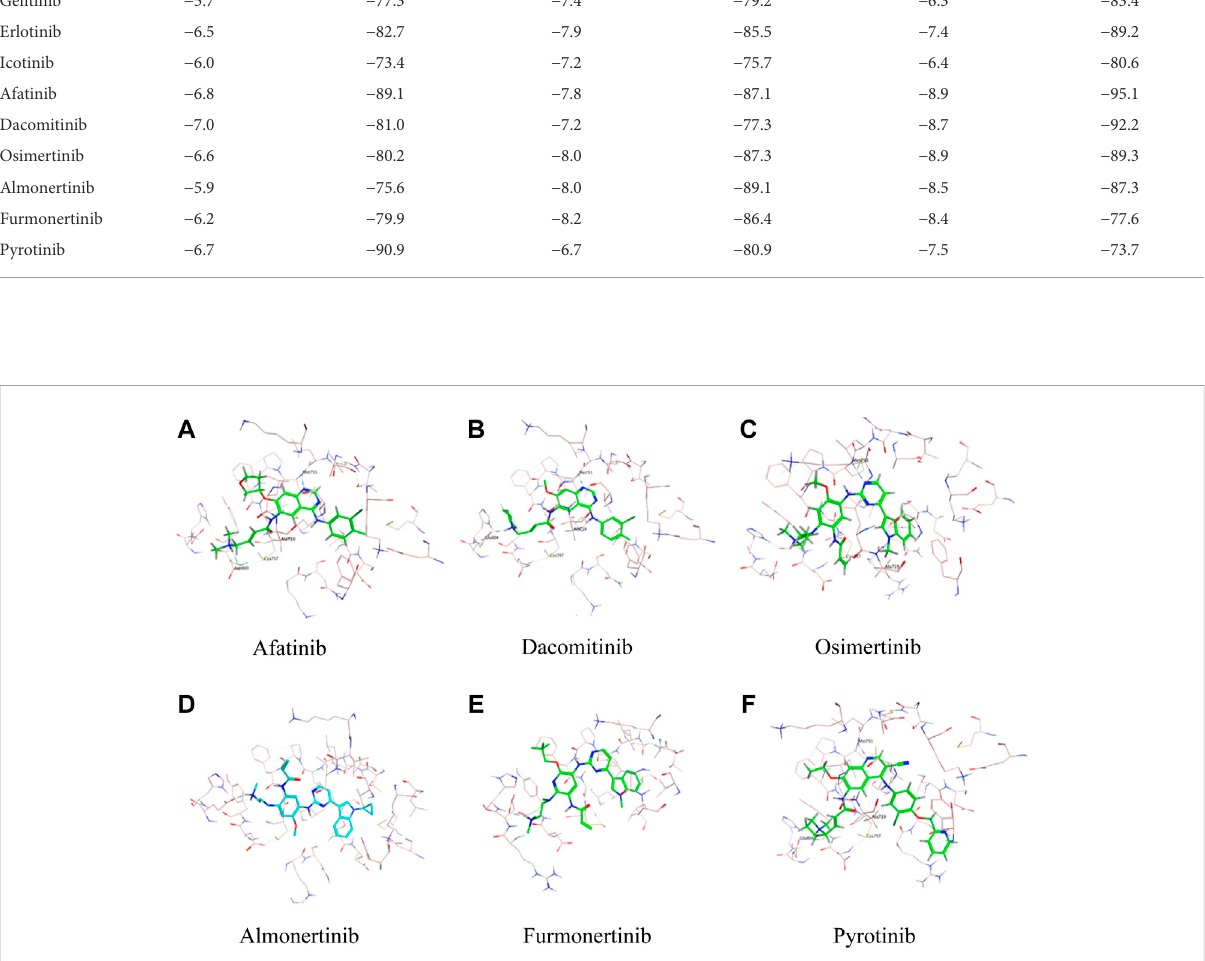
FIGURE 4 Binding modes of different TKIs Afatinib (A) , Dacomitinib (B) , Osimertinib (C) , Almonertinib (D) , Furmonertinib (E) , and Pyrotinib (F) to G719A